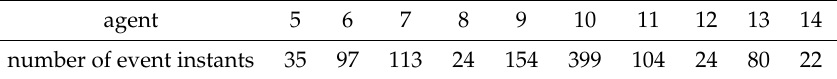
Table 6. Number of event instants of each agent ( τ = 0.5, 50